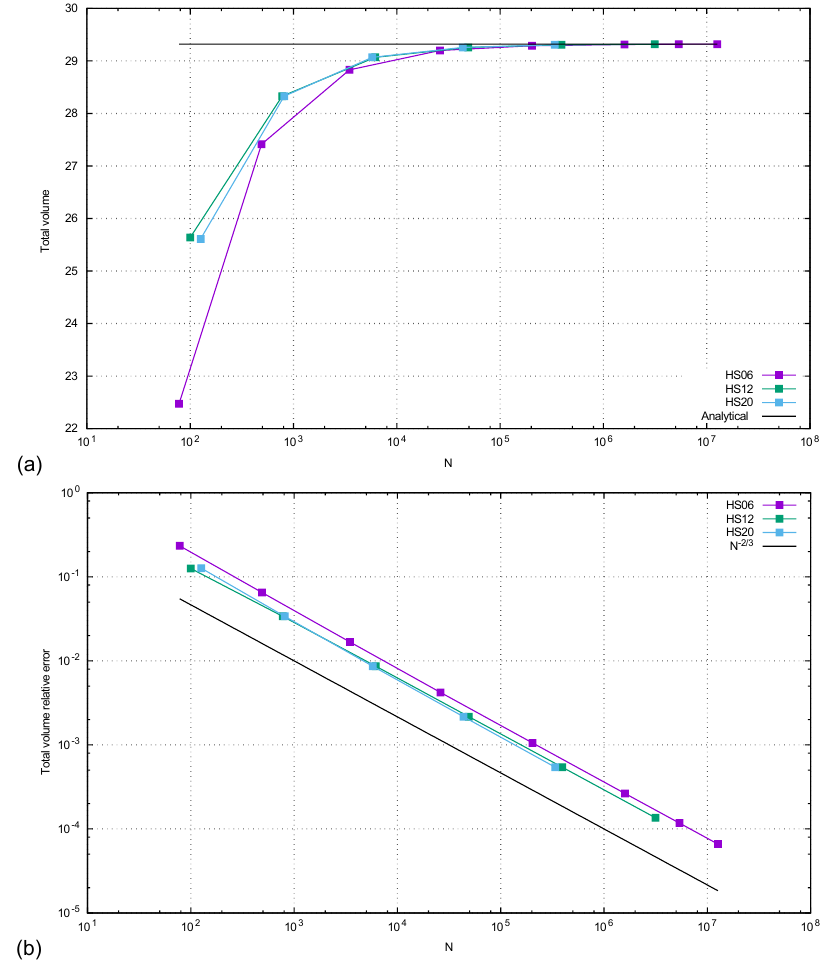
Figure 7. (a) Measured total volume for all three shells as a function of the number of nodes ( N ). (b) Corresponding total volume relative error as a function of N .